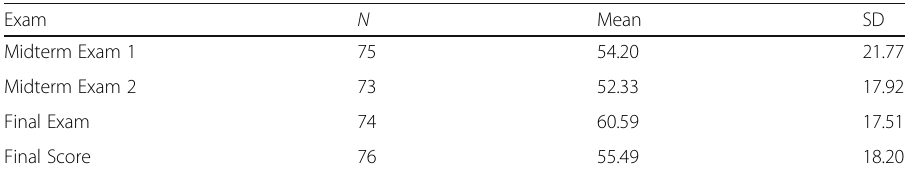
Table 1 Descriptive Statistics for Academic